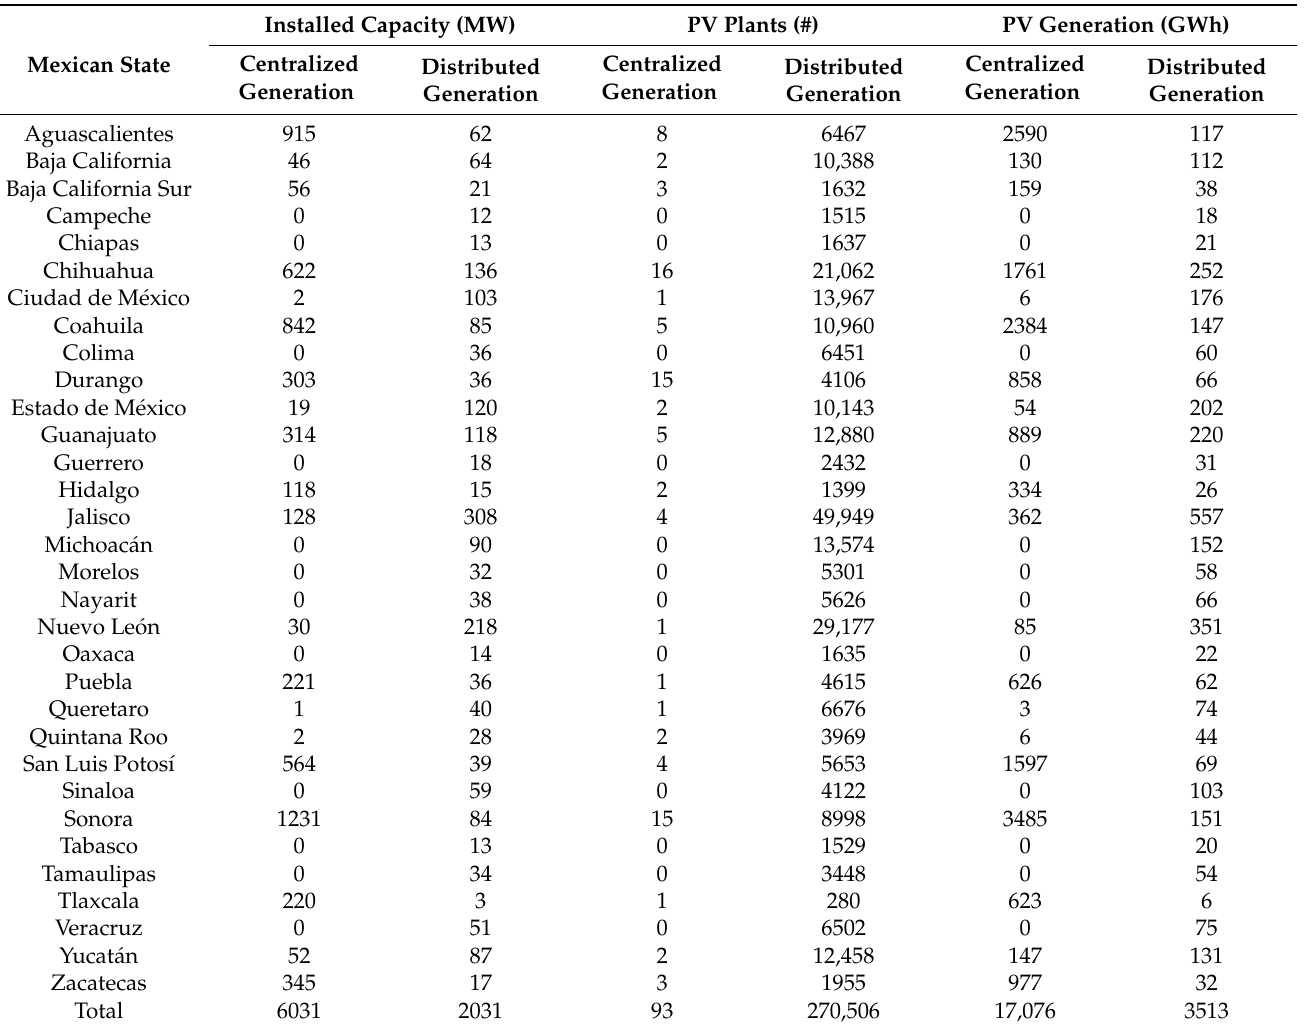
Table 3. PV generation power plants in Mexico,